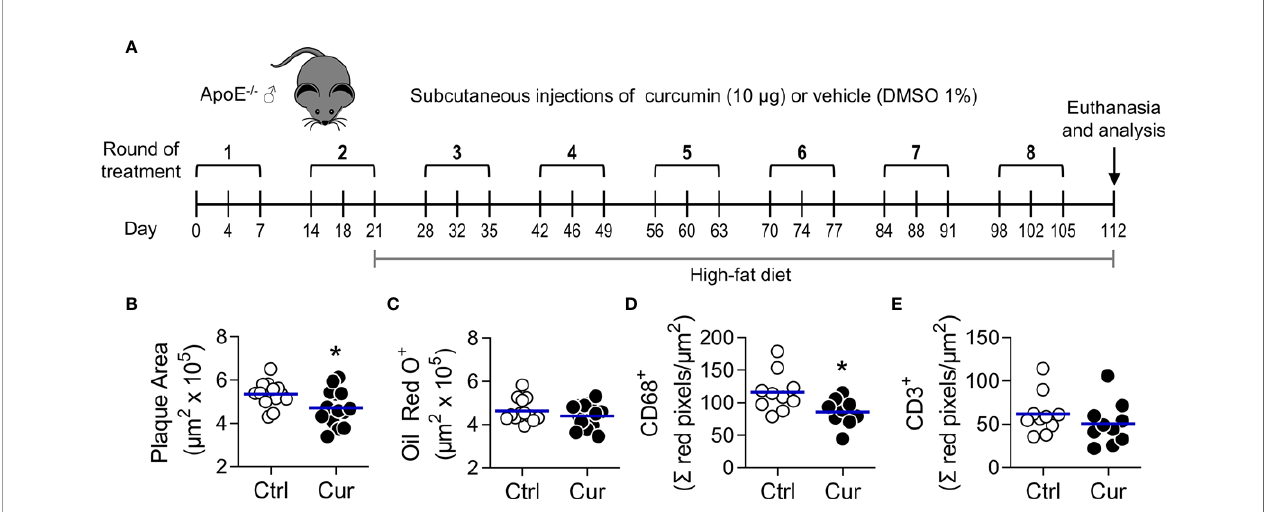
FIGURE 1 | Subcutaneous microdose delivery of curcumin attenuates atherosclerosis development in dyslipidemic ApoE -/- mice. (A) ApoE-/- mice were treated three times a week (1 round of treatment), with subcutaneous injections of curcumin (Cur, 10 µg) or vehicle (Ctrl, DMSO 1%) for 8 rounds every other week, and fed a high-fat diet (HFD), as shown. Animal euthanasia was performed on day 112, and samples were collected and processed as indicated in Materials and Methods. (B, C) Cryosections from the aortic root were stained with (B) H&E and (C) Oil red O, to quantify plaque area and lipid deposition, respectively. (D, E) The extent of (D) macrophage (CD68 + ) and (E) T cell (CD3 + ) in fi ltration in aortic root cryosections was also assessed by immuno fl uorescent staining. The areas of the atheromatous lesions, lipid deposition, as well as the macrophage and T cell in fi ltrates were calculated with an image analysis software (see Materials and Methods ). Each point represents the average area per mouse (7-9 sections/mouse), and bars represent the mean of 10-15 mice. *P<0.05 (Mann-Whitney U test). In repetition experiments, similar reductions in the atheromatous plaque area were observed ( Supplementary Figure S1